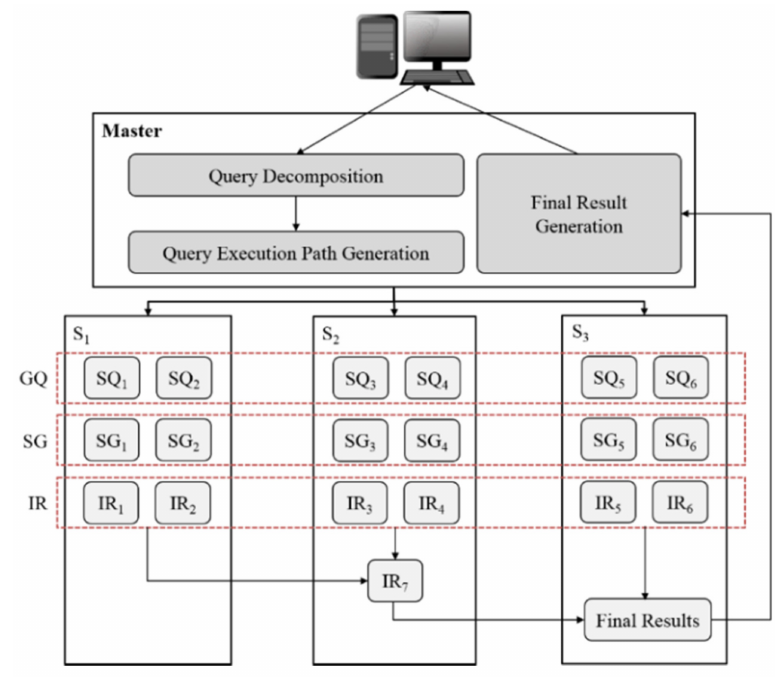
Figure 1. Overall architecture of the proposed